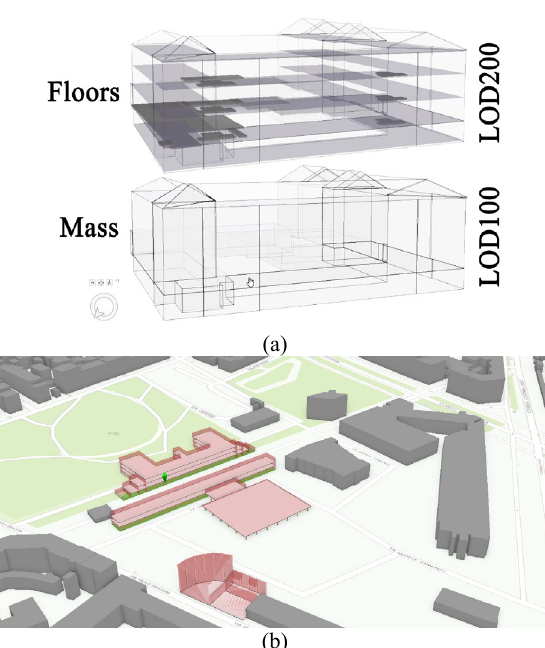
Figure 8. LOD 200 parametric model visualization and exploration into GIS